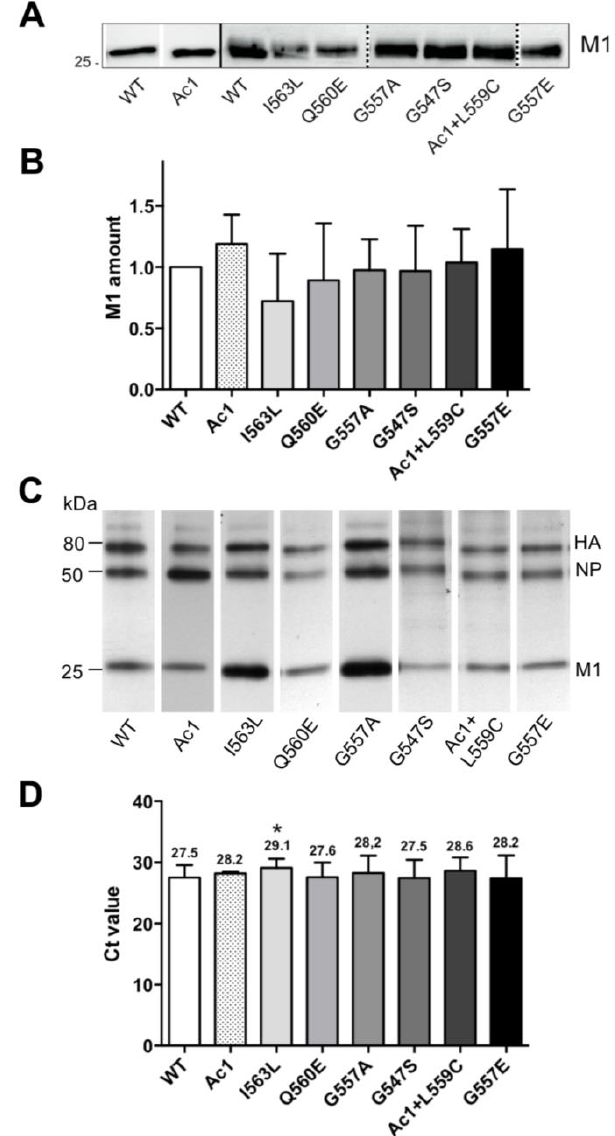
Figure 4. M1 and RNP content of recombinant virus particles with mutations in HA. MDCK cells were infected with an m.o.i. of four. After 24 h, the cell culture supernatant was harvested and adjusted to a HA titer of 2 6 . ( A ) Aliquots were subjected to SDS-PAGE and Western blotting to detect M1. Solid lines between lanes separate different blots, whereas samples separated by dashed line were run on the same gel, but irrelevant lanes were removed; ( B ) M1 bands were quantified by chemiluminescence, normalized to wild type and results from three virus infections are displayed as mean ± SD. A Student´s t -test (unpaired, two-tailed) revealed no significant difference in the HA/M1 ratio between wild type and mutant virus particles; ( C ) Protein composition of virus particles metabolically labelled with [ 35 S ]-methionine. Band intensities from this film were quantified by densitometry and revealed the following results for the relative abundance of viral proteins: WT: HA 32%, NP 34%, M1 34%; Ac1: HA 27%, NP 43%, M1 30%; I563L: HA 20%, NP 20%, M1 60%; Q560E: HA 35%, NP 31%, M1 34%; G557A: HA 32%, NP 39%, M1 29%; G547S: HA 40%, NP 40 %, M1 20%; Ac1 + L559C: HA 32%, NP 41%, M1 27%; G557E: HA 32%, NP 39%, M1 29%; ( D ) Real-time PCR with M1 specific primers. The mean C t value ± SD is shown for wild type and each mutant and was determined from three independent virus infections. A Student´s t -test (unpaired, two-tailed) revealed a significant difference in the HA/RNP ratio between wild type and mutant virus particles only for the mutant I563L, which is indicated by an asterisk ( p < 0.05).